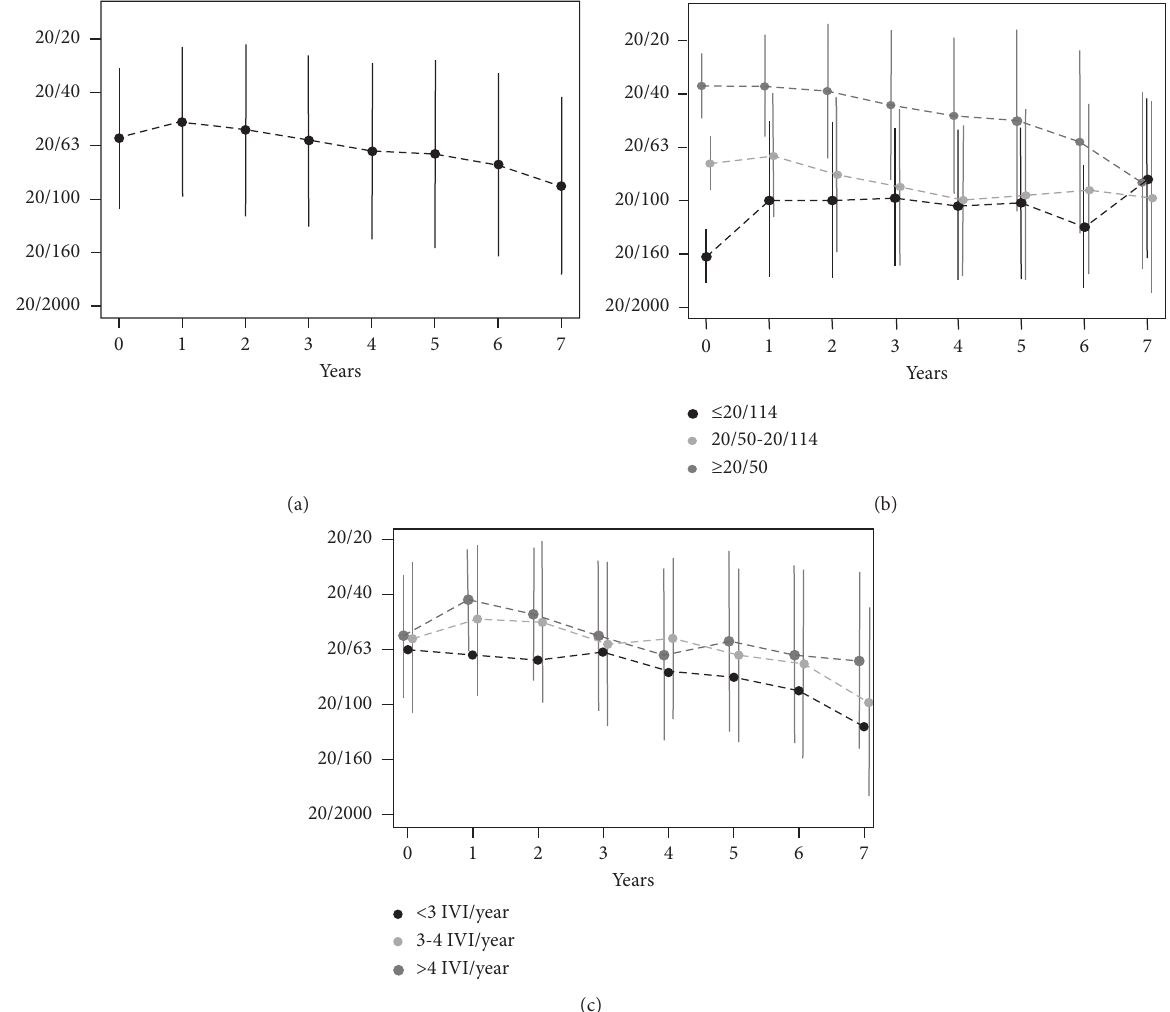
Figure 2: Mean visual acuity (VA) measured by Early Treatment Diabetic Retinopathy Study (ETDRS) charts at 4 meters and converted to Snellen over 7 years. (a) Mean change of VA for all eyes. (b) Mean change of VA separated in eyes with good baseline VA ≥ 20/50 (0.7 ETDRS), intermediate VA 20/50–20/114 (0.7–0.35 ETDRS), and minor VA ≤ 20/114 (0.35 ETDRS). (c) Mean change of VA subdivided into three groups based on the average numbers of intravitreal injections per